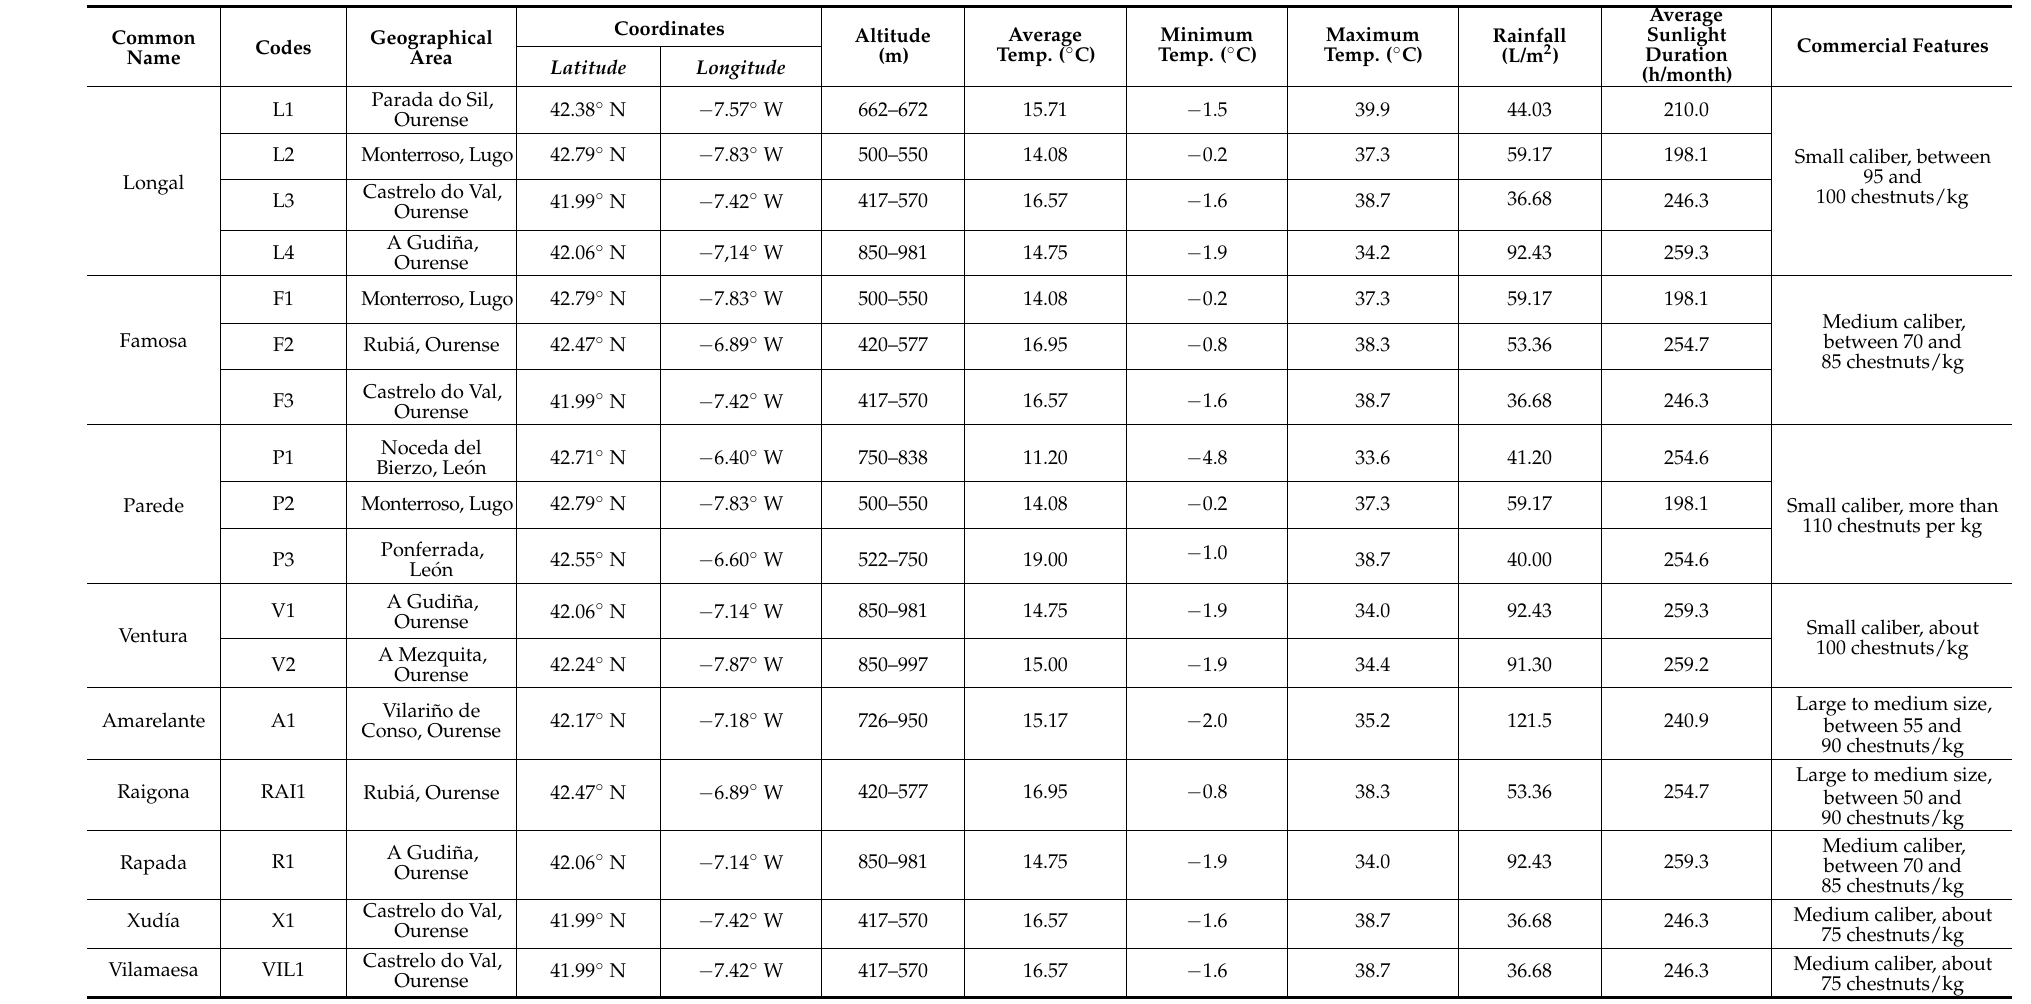
Table 1. Information of chestnut samples used in the study and of the geographical areas. It was collected in northwest Spain (between May and October 2015, a period that corresponds to the beginning of the vegetative period and maturation of the fruit). Data were obtained from Meteogalicia (Meteorology Agency of Galicia) and AEMET (Meteorology Statal